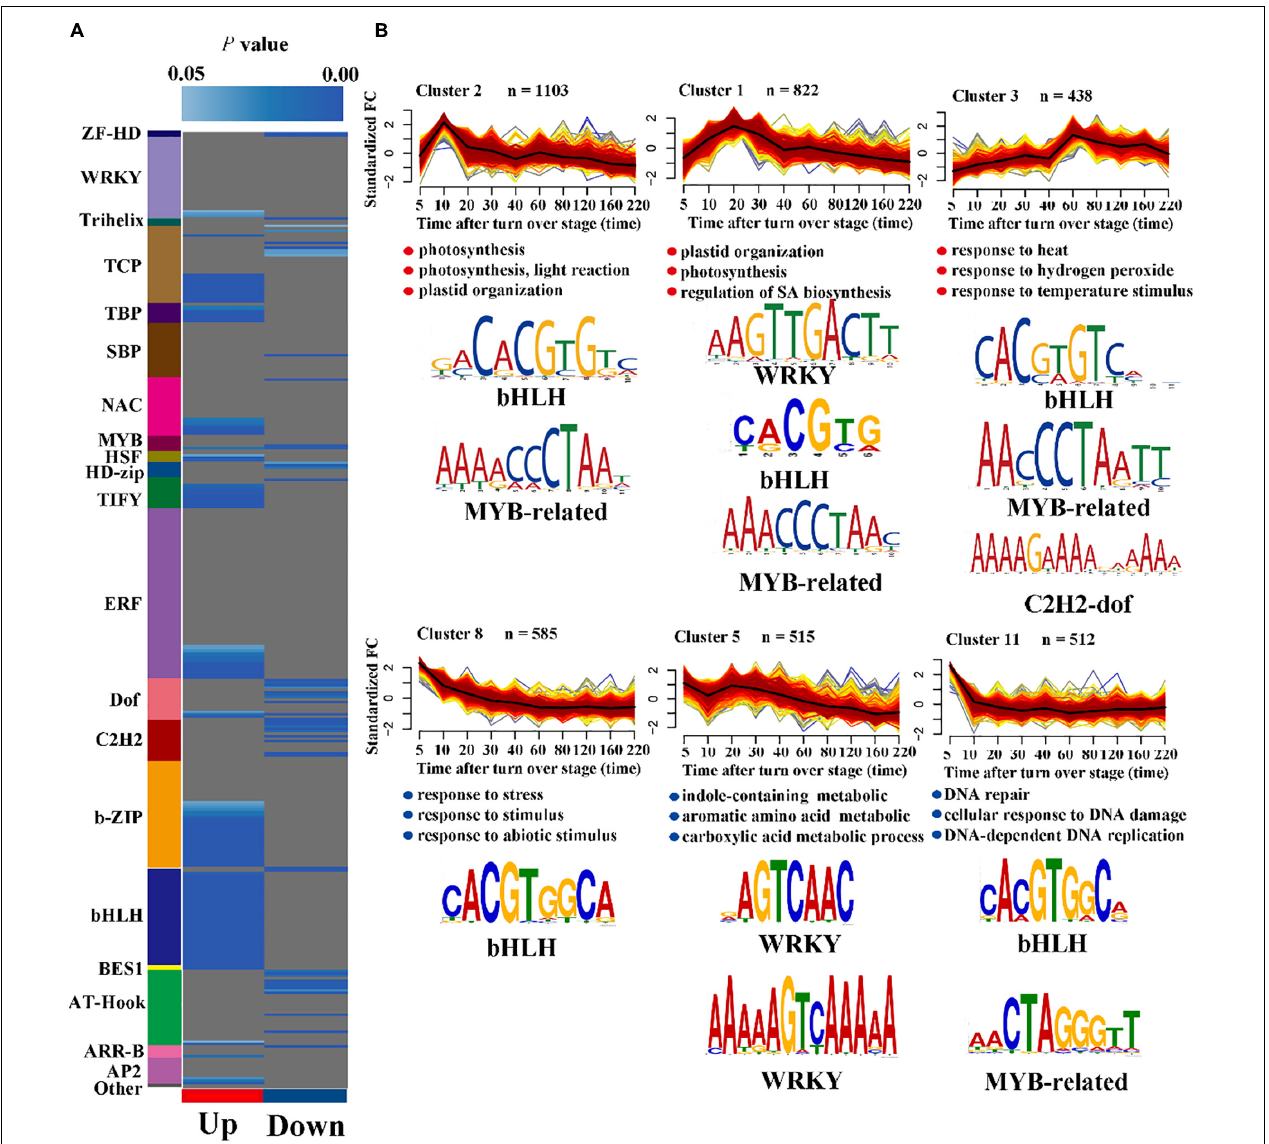
FIGURE 3 | Enriched TF corresponding motifs and GO enrichment analysis in a wounding-responsive cluster. (A) The overrepresentation of TF binding motif within the up- and down-regulated cluster. Different color blocks represent different transcription factor families. Blue indicates a motif that is significantly overrepresented in the up- or down-cluster (cumulative hypergeometric distribution). (B) Typical co-expression clusters (line chart) with their newly discovered ( de novo ) TF-corresponding motifs ( p < 0.01, cumulative hypergeometric distribution). The blue dots represent the significantly enriched GO terms (full GO results are available in Supplementary Dataset 4